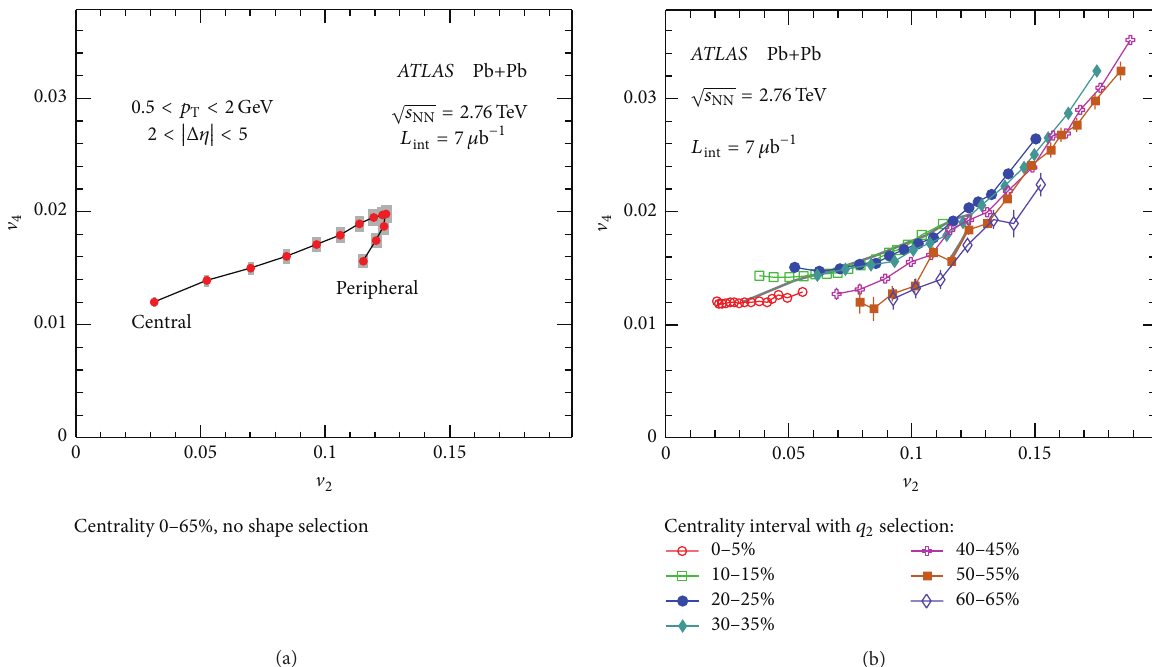
Figure 4: The correlation of V 2 ( 𝑥 -axis) with V 4 ( 𝑦 -axis) measured in 0.5 < 𝑝 𝑇 < 2 GeV/ 𝑐 . (a) shows V 2 and V 3 values for fourteen 5% centrality intervals over the centrality range of 0–70% without event shape selection. (b) shows V 2 and V 4 values in 15 𝑞 2 intervals in seven centrality ranges (markers) with larger V 2 value corresponding to larger 𝑞 2 value. Figures are taken from